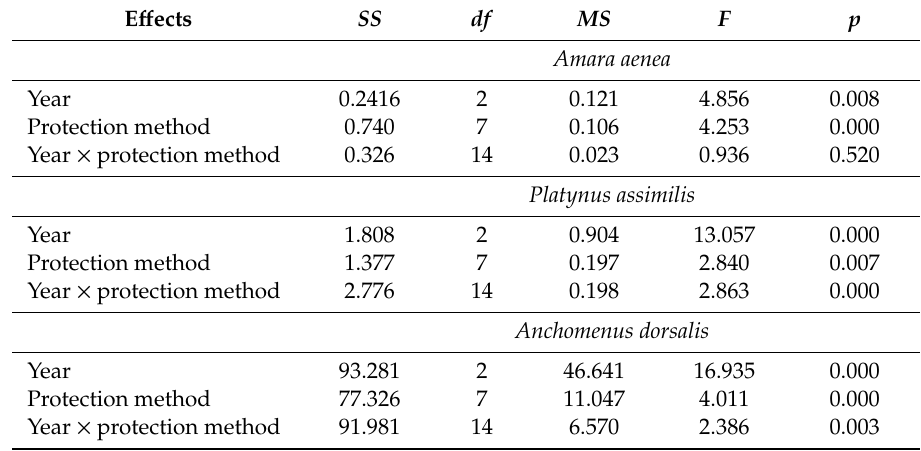
Figure 3. Number of trapped individuals of ( a ) Carabidae, ( b ) Staphylinidae, and ( c ) Formicidae in broad bean crop depending on the protection method used: Treatments are the same as in Table 1. Vertical bars denote 0.95 confidence intervals. Means followed by the same letters are not significantly different according to the LSD test ( p < 0.05), factors: year x protection method. Table 4. Results of the statistical analysis of the presence of selected Carabidae species (other results are presented in Table S2). SS —sum of squares, df —degrees of freedom, MS —mean squares, F —Fisher-Snedecor’s test, p —probability